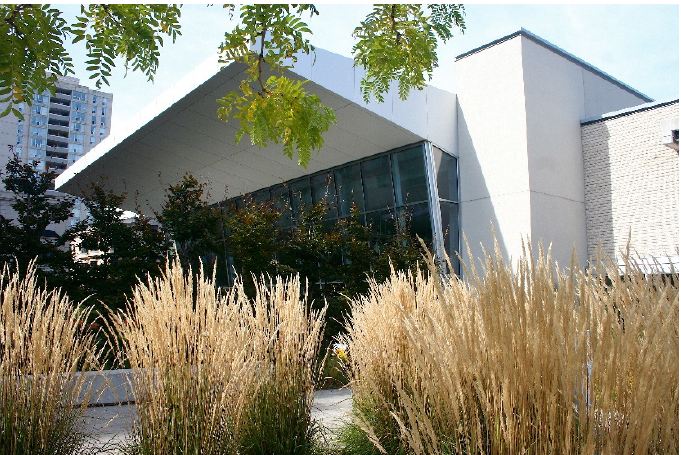
Figure 22. A view towards the iconic projecting roof canopy passed the wild grasses and beech hedge meant to reflect pre-settlement landscapes (Credit: Roberto Chiotti).